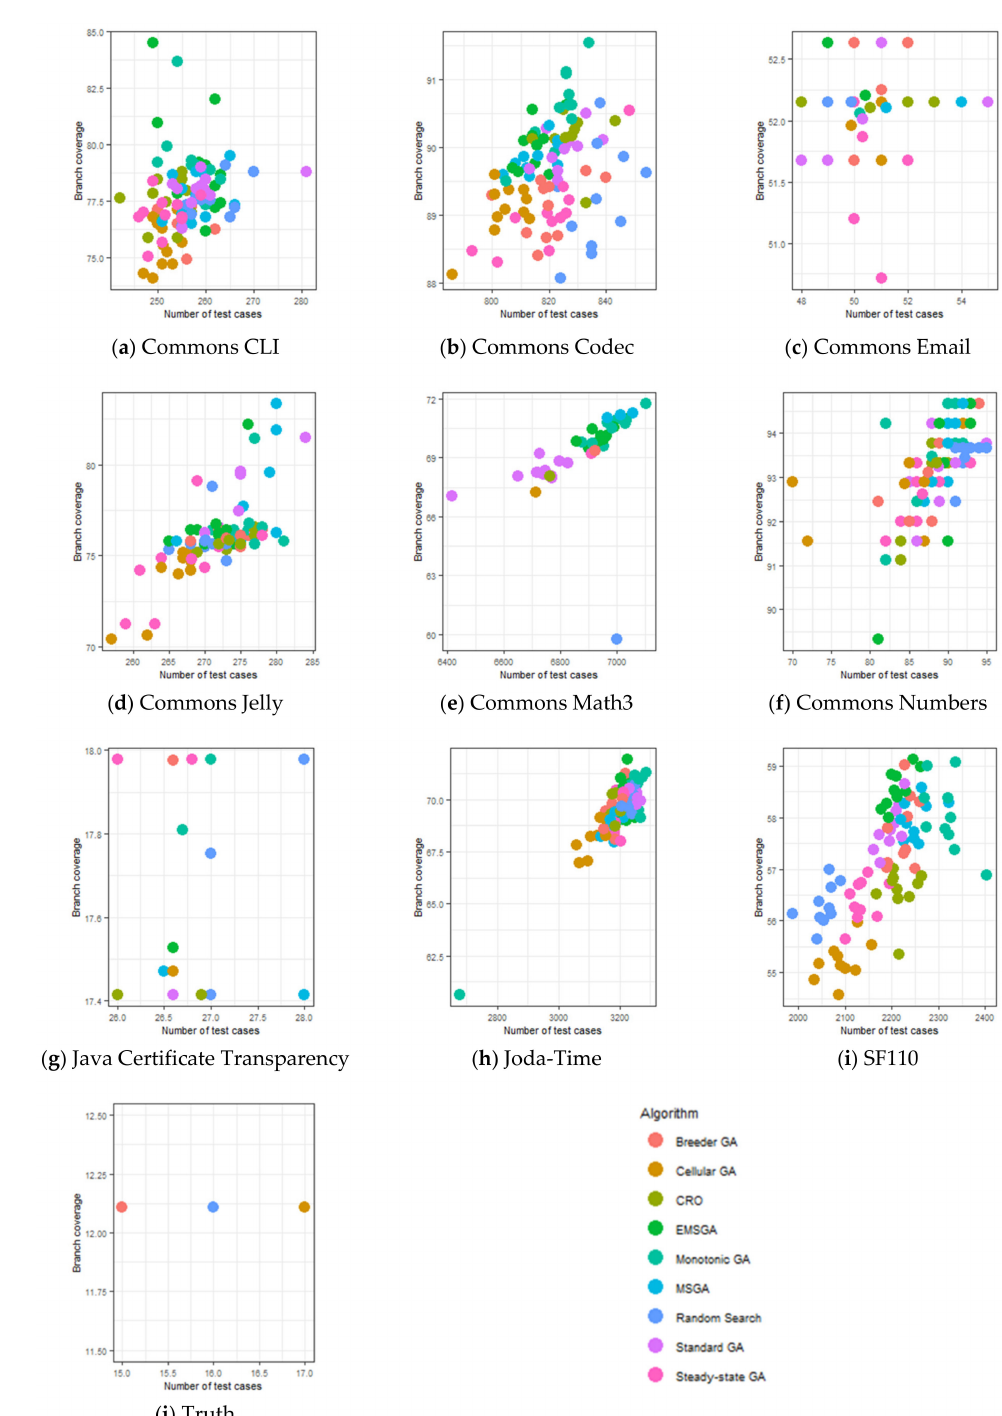
Figure 7. Problem instances that were evaluated with each